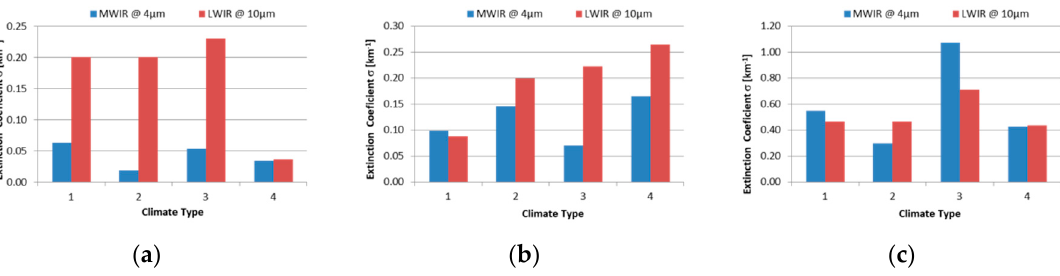
Figure 7. Atmospheric attenuation coefficient’s dependence on meteorological visibility, climate type (1—Mid-latitude summer urban; 2—Tropical desert, 3—Tropical navy aerosol; 4—U.S. standard 1976 rural) and imager spectral sensitivity in the case of: ( a ) good visibility—23 km, ( b ) medium visibility—5 km, ( c ) bad visibility—1 km.